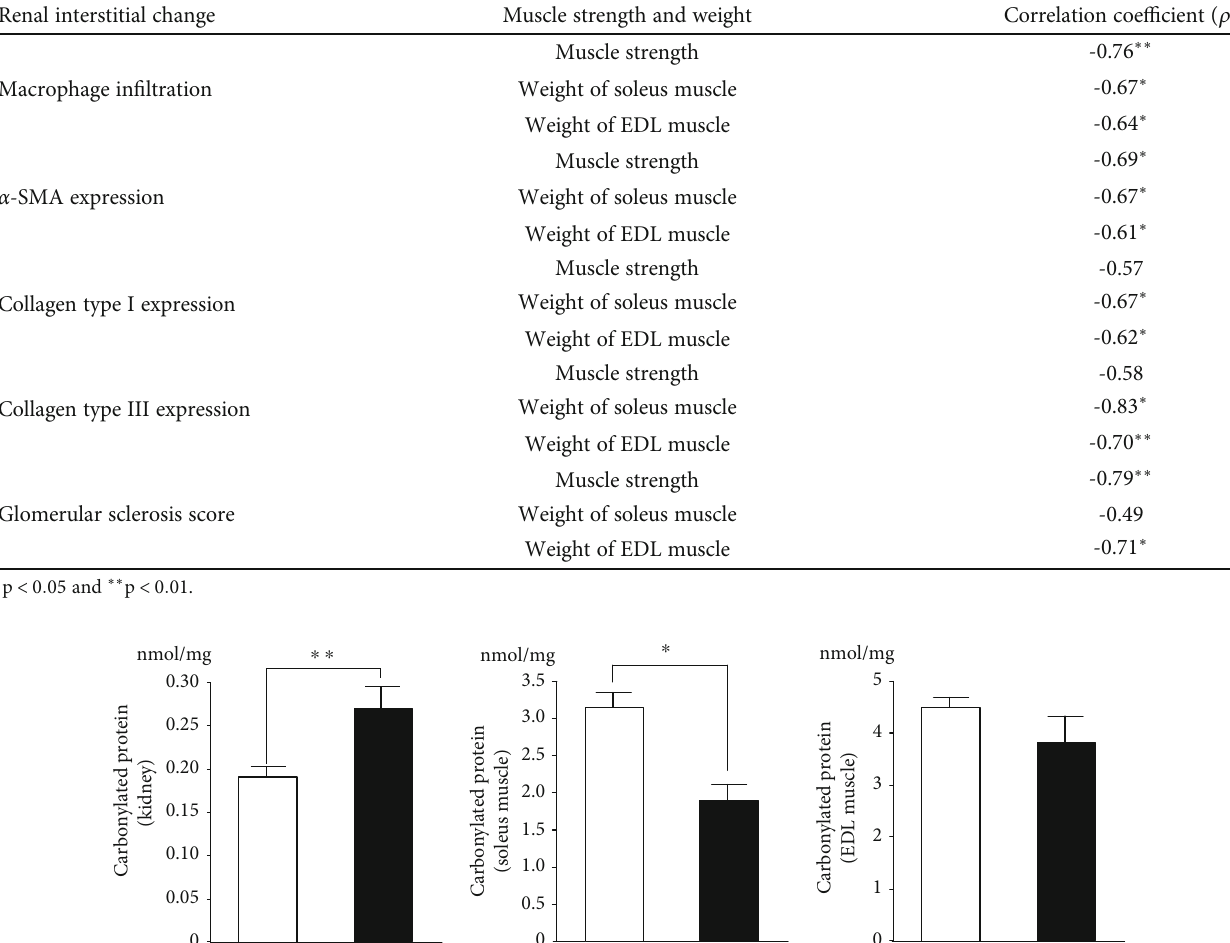
Table 3: Relationships between renal morphological change and muscle strength, and weights of the soleus and extensor digitorum longus (EDL) muscles in 24-week-old SD and SDT fatty rats.